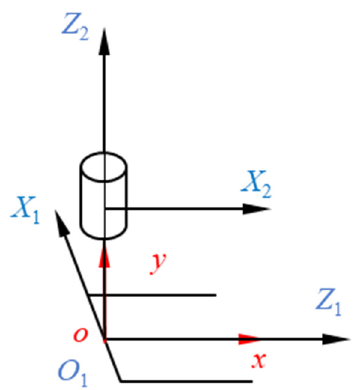
Figure 4. Finite element global coordinate system of the robotic arm.